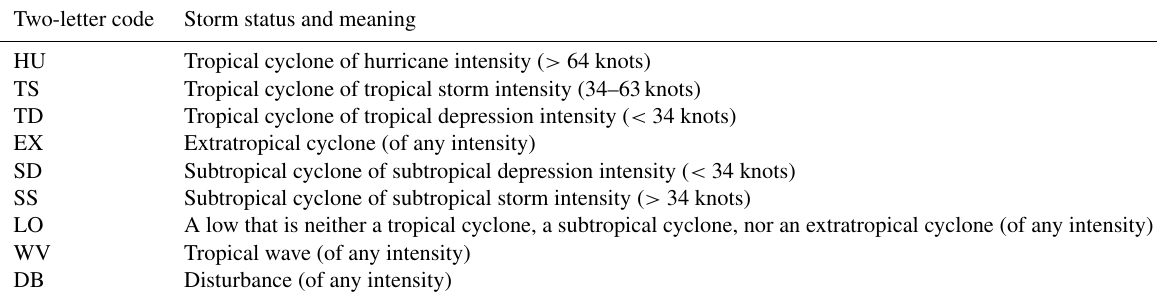
Table A1. HURDAT2 cyclone categories/status.